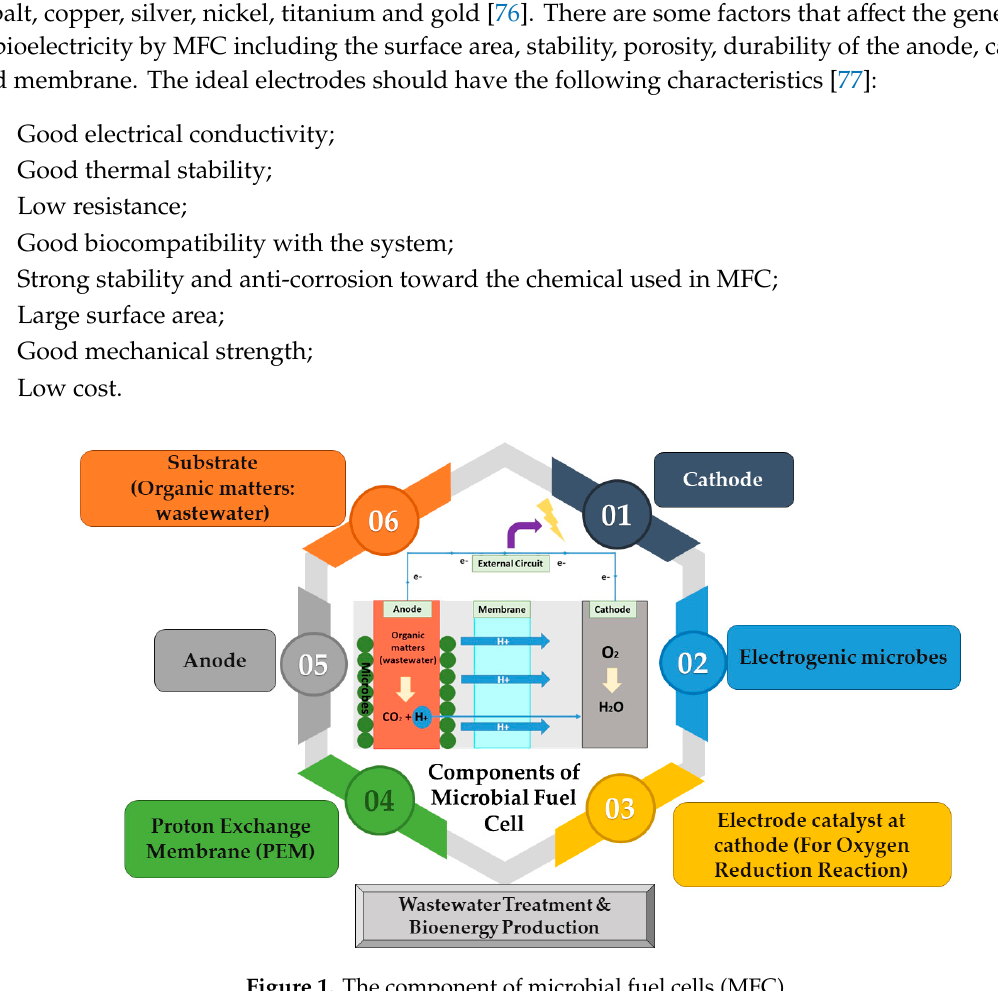
Figure 2. Advantages and disadvantages of microbial fuel cells (MFC).